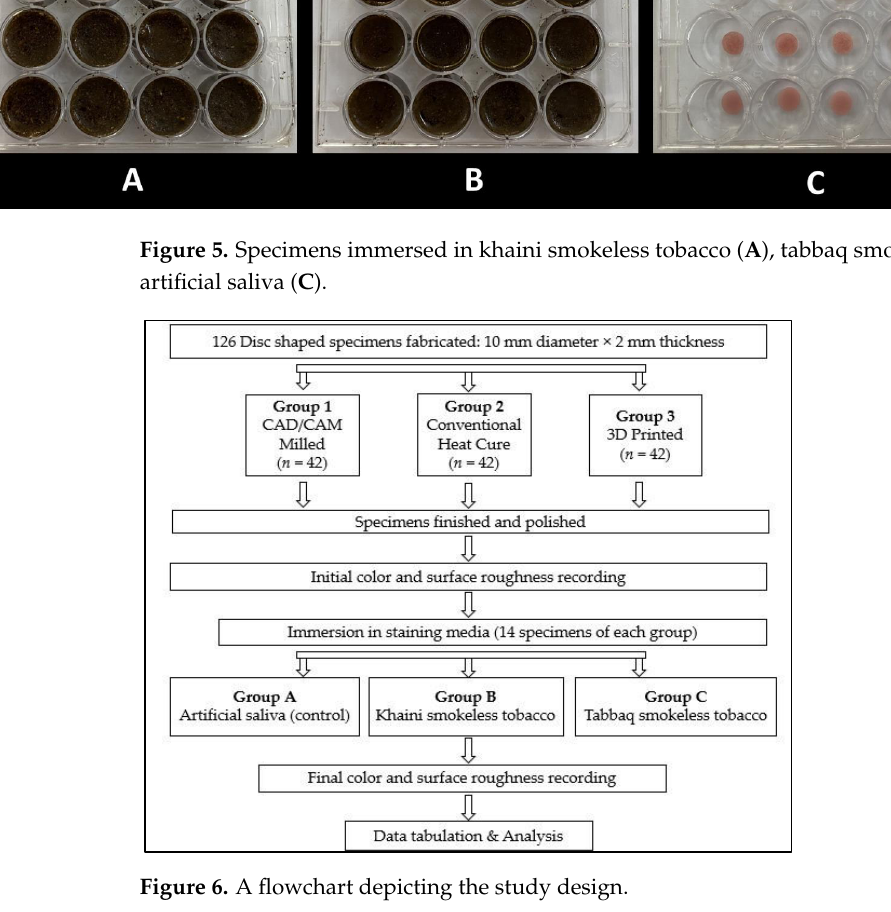
For the final color and surface-roughness readings, measurements were taken using the same protocol as that for the initial color and surface-roughness readings. The CIELAB color-difference formula was used to calculate the changes in color as shown in Equation (1) [38,39]: